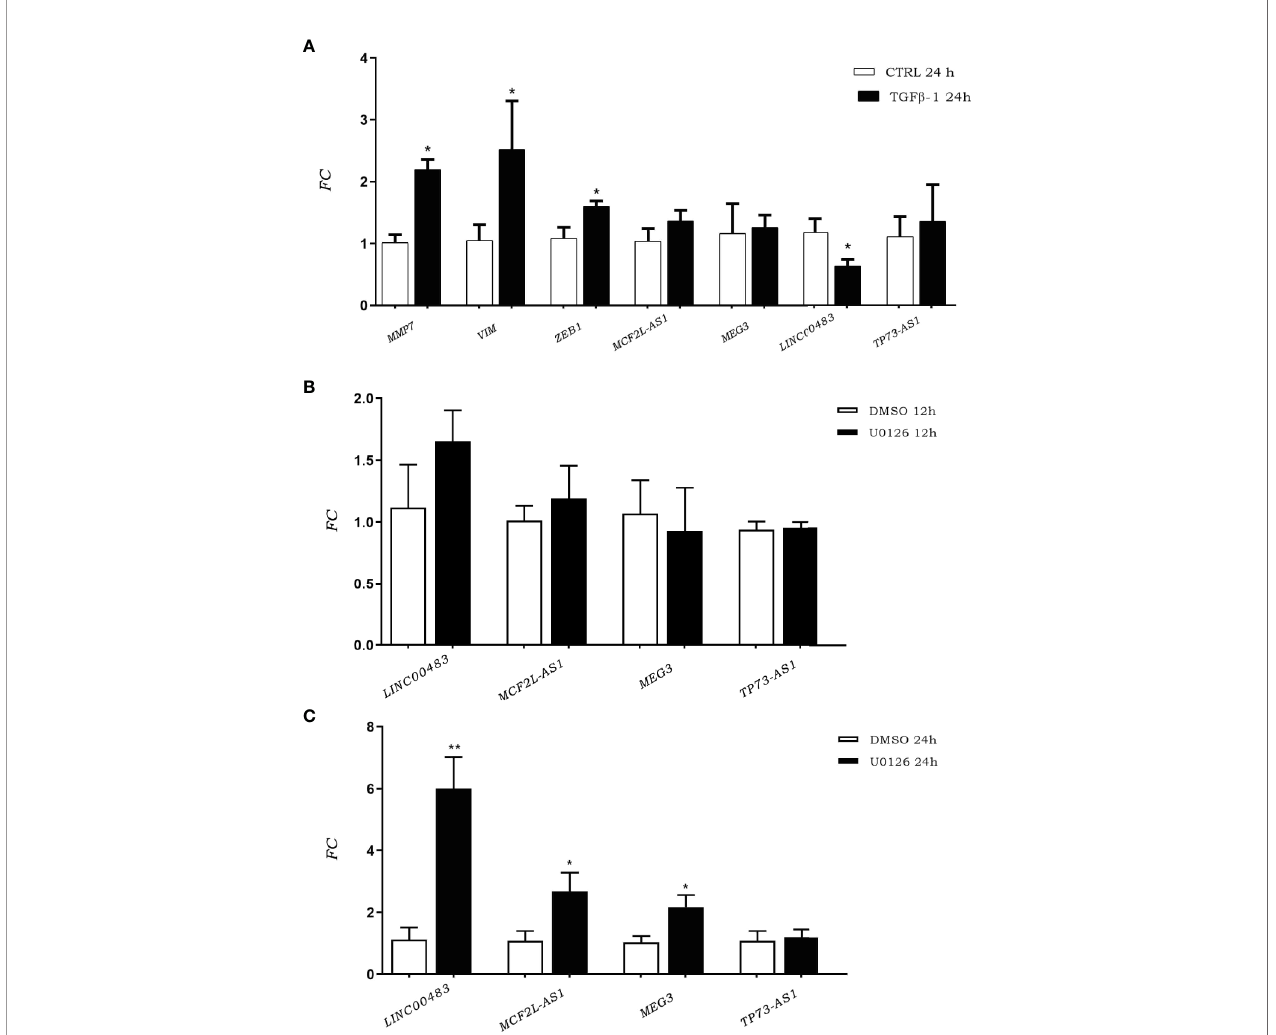
FIGURE 3 | (A) Expression of epithelial – mesenchymal transition (EMT) gene markers and DE long non-coding RNA (lncRNA) expression after TGF b -1 treatment. (B) LncRNA expression in HCT-116 cell line post treatment with U0126 12 h and 24 h (C) . *p-value<0.05;